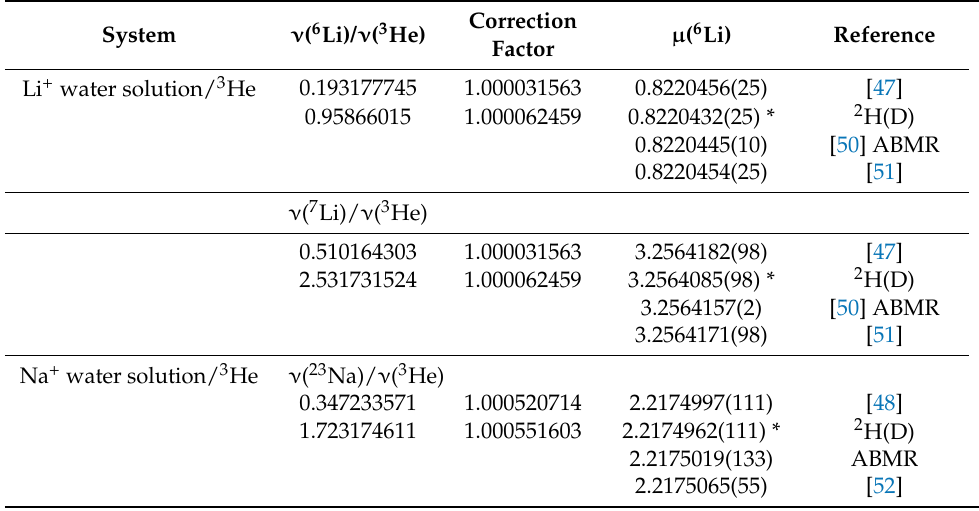
Table 5. NMR parameters for the calculation of 6/7 Li and 23 Na nuclear magnetic moments from water solutions. * NMM calculated from 2 H(D)